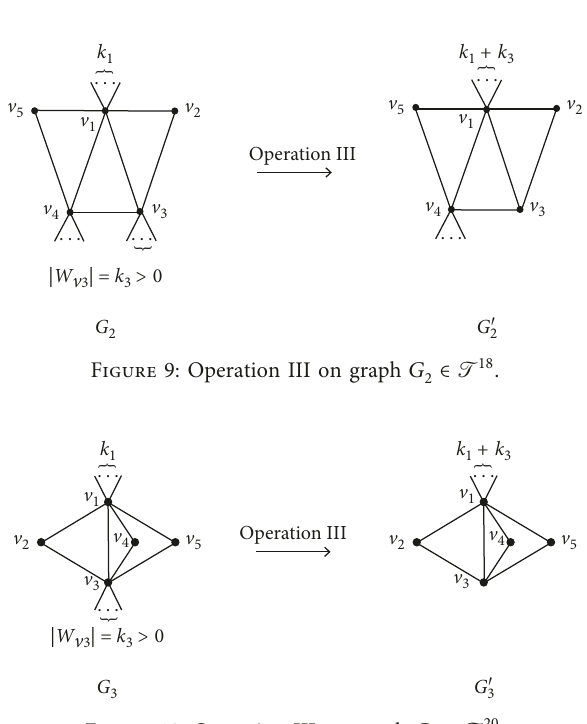
Figure 8: Operation III on graph G